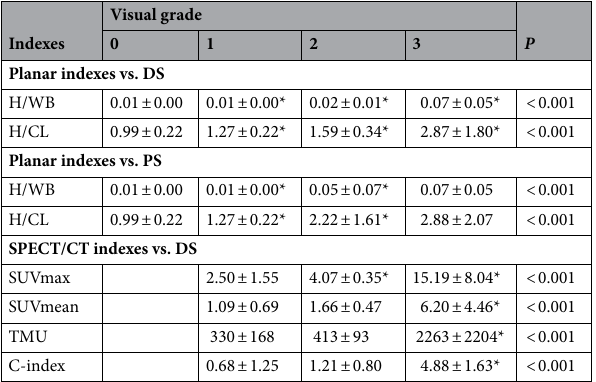
Table 2. Quantitative indexes according to the visual grades. The quantitative indexes were represented as mean ± 1.96 SD. *significantly different from the value of immediate lower grade.